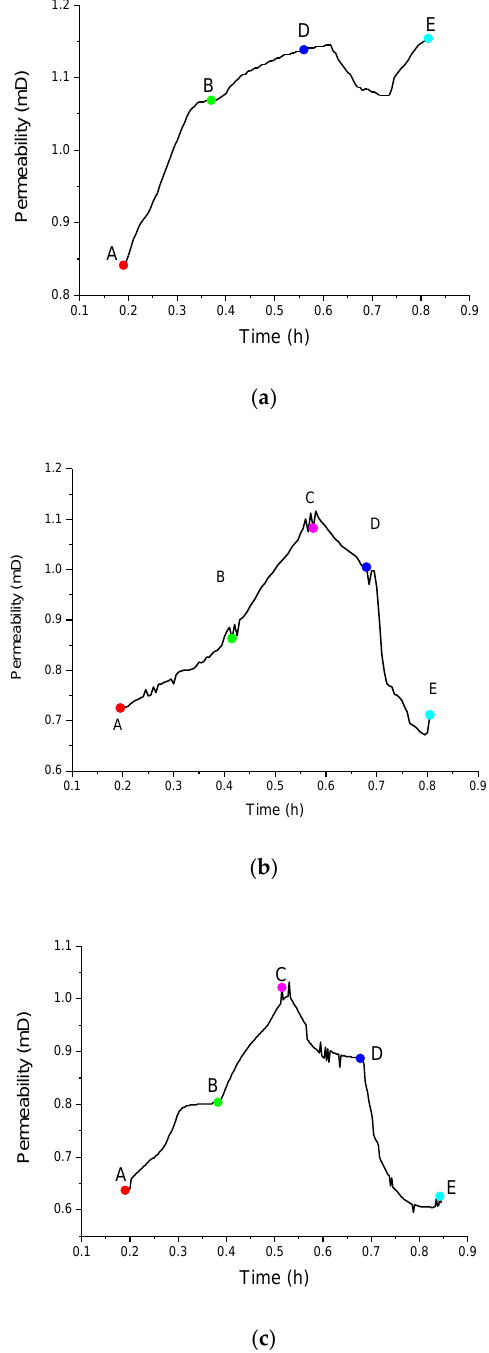
Figure 7. Permeability evolution with time of coal samples. ( a ) Coal sample M1; ( b ) coal sample M2; ( c ) coal sample M3. Note: Point A is the unloading axial stress point; Point B is the unloading confining pressure point; Point C is the loading confining pressure point; Point D is the loading axial stress point; Point E is the secondary damage